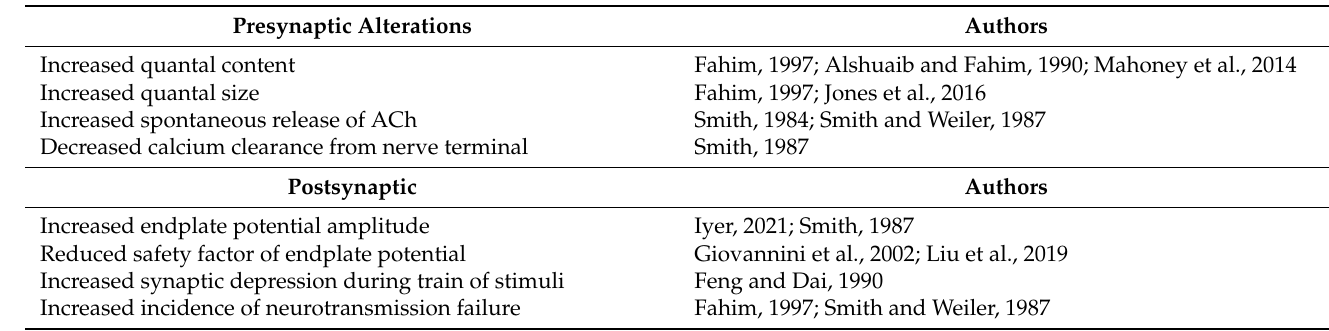
Table 2. Physiological Adaptations of the NMJ to